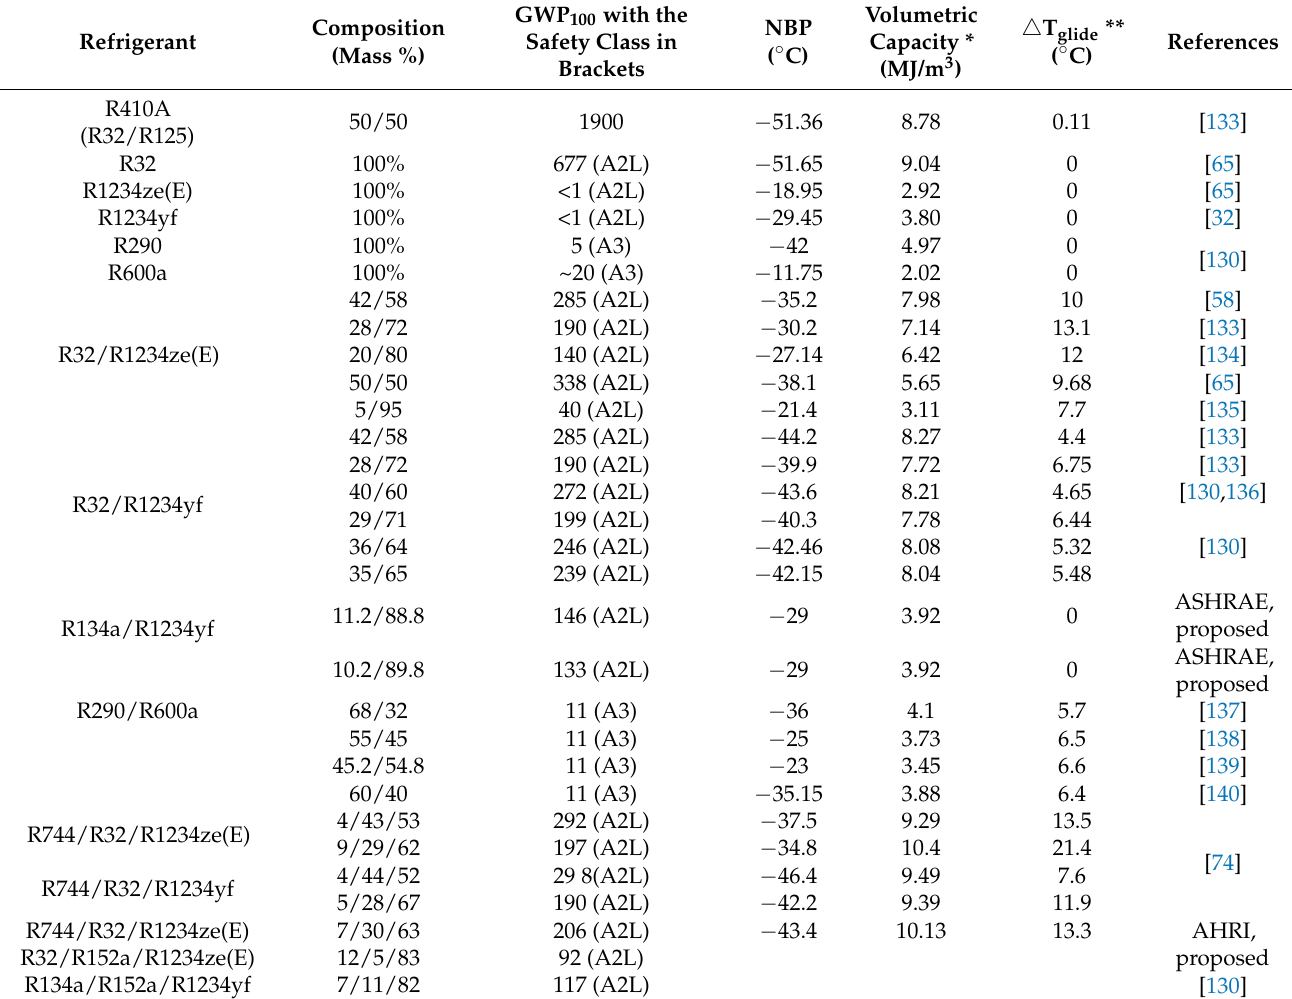
Table 5. Literature review of pure/binary/ternary mixtures of low-GWP refrigerants.